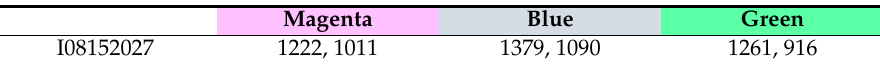
Table 4. Coordinates of the cropped areas used to represent the DCS color units. Each cropped area is a 9-by-9 pixel square whose upper left corner is located at the specified coordinate. See boxes in Figure 21b. Magenta Blue Green I08152027 1222, 1011 1379, 1090 1261, 916